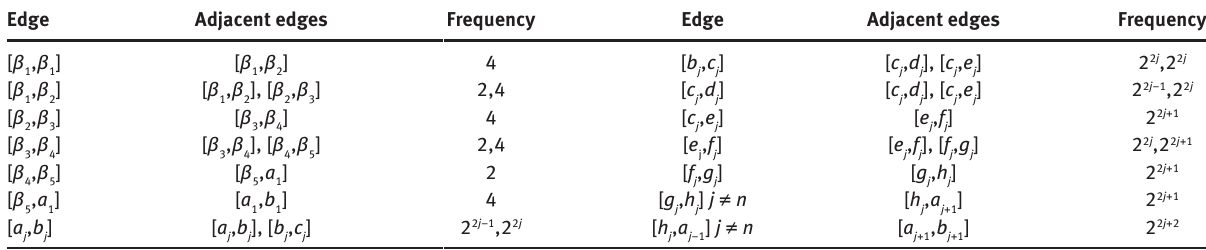
Table 4: Edge partition with respect to the pairs of end vertices of sets A and B , their corresponding adjacent edges and frequencies of occurrence for n ≥ 1.